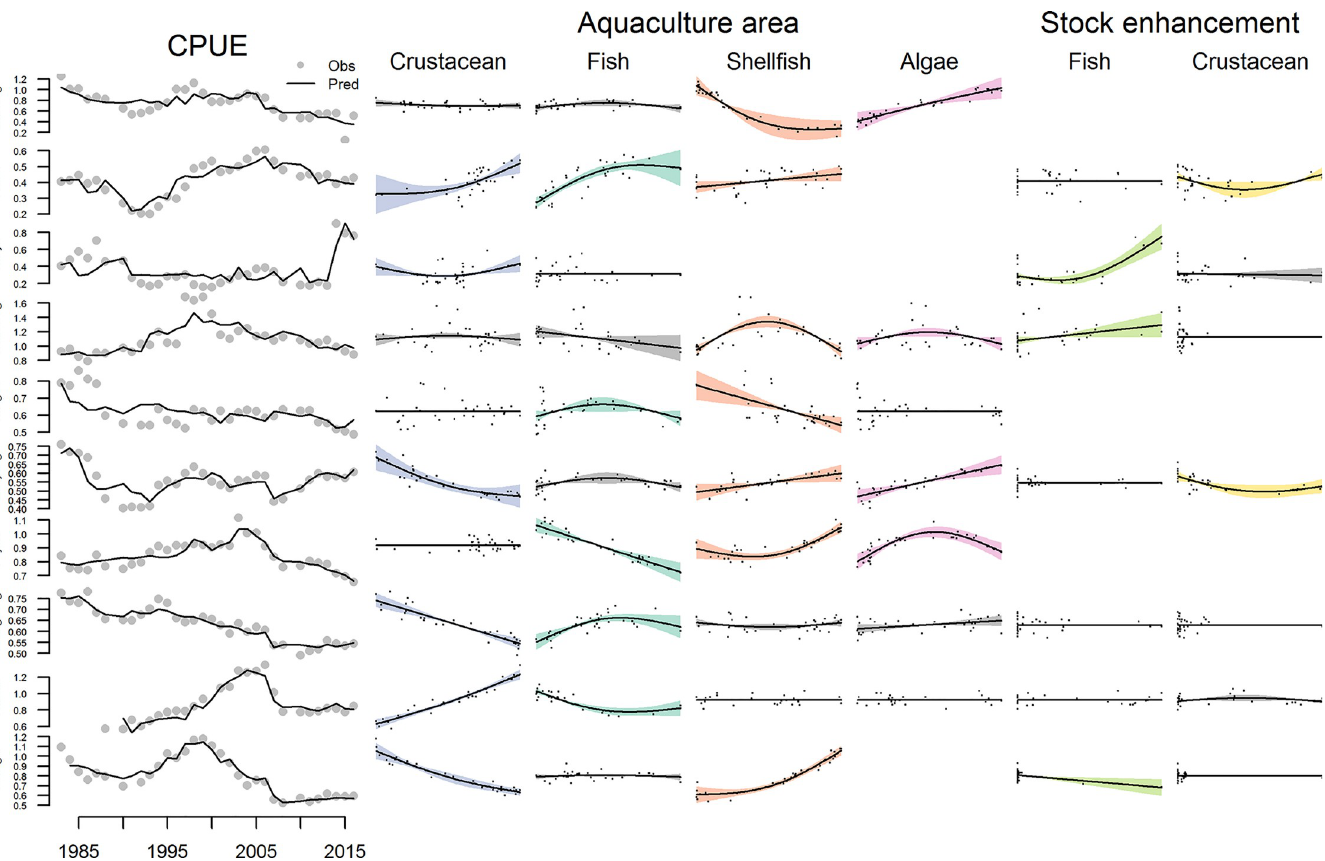
Fig 10. Fits (black lines; left column) of GAMs predicting province level catch per unit effort data (grey dots; left column) by the area of aquaculture by product and the amount of stock enhancement by product. Plots of the relationships between aquaculture area or stock enhancement and CPUE in color indicate a significant relationship (p < = 0.05).